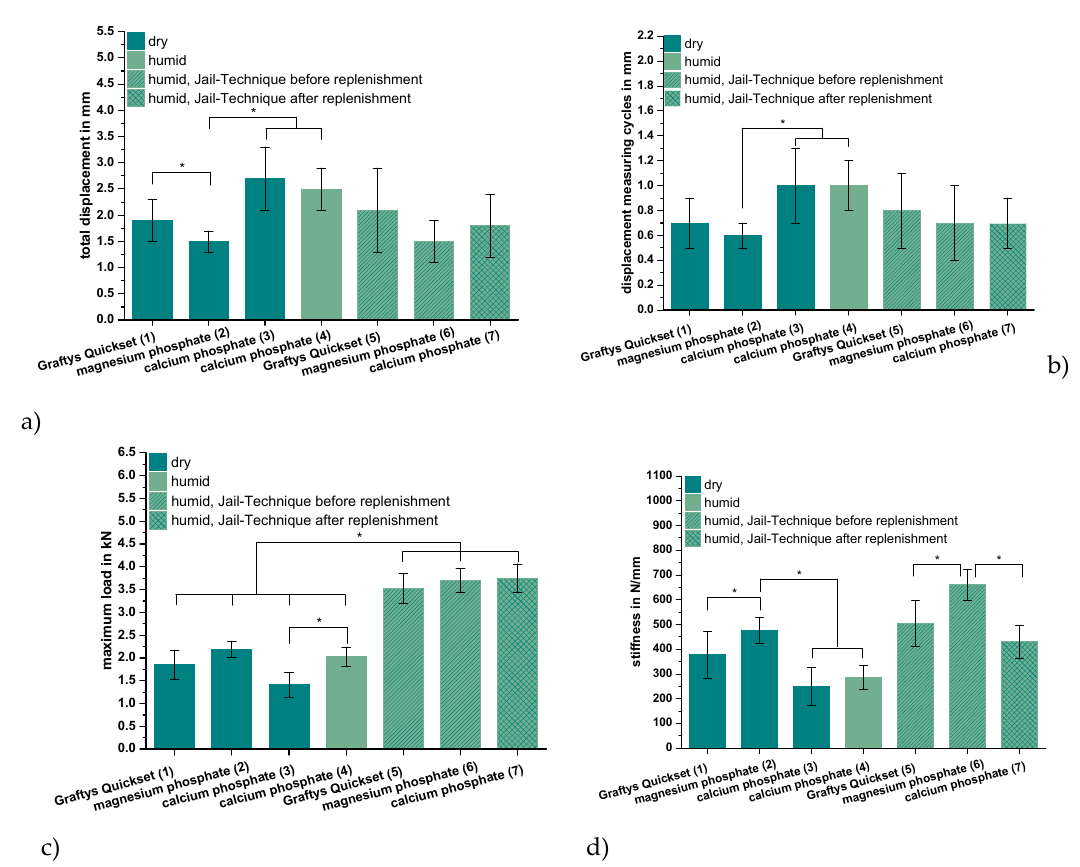
Figure 9. Displacement, maximum load, and sti ff ness of the dynamic tests. Displacement of the augmented tibial fractures during whole test protocol, including ( a ) settling cycles and ( b ) during the measuring cycles only, ( c ) maximum load, and ( d ) sti ff ness of the constructs after 24 h of setting in dry (groups 1–3) and humid conditions (groups 4–7) at 37 ◦ C, are shown. Augmentation was based on commercial Graftys ® Quickset (groups 1,5) and in-house-prepared dual setting calcium phosphate (groups 3,4,7) and magnesium phosphate (groups 2,6). Pure augmentation was done in groups 1–4, whereas, in groups 5 and 6, a jail technique was applied additionally before and, in group 7, after replenishment, depending on the drillability of the cement. Pure augmentation with magnesium phosphate showed significant lower values compared to other groups in terms of both total displacement and displacement in measuring cycles only (groups 2,3; groups 2,4; significant di ff erence between group 1,2 only for total displacement) ( a , b ). Regarding the maximum load, the humid CPC revealed a significant higher maximum load than the CPC stored under dry conditions (groups 3,4). All di ff erences between the groups with bone substitute only (groups 1–4) and the groups with the screws in the jail technique (groups 5–7) were significant ( c ). Concerning the sti ff ness, the MPC exhibited the significant highest values in the group with bone substitute only (groups 1–4) and in the group with osteosynthesis (groups 5–7). The sti ff ness was calculated as a measure for the ascending slope during the elastic deformation ( d ). Significant di ff erences (*) were set at p < 0.01 each.